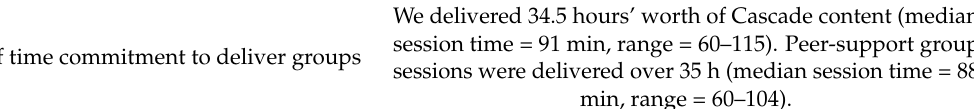
Table 4. Feasibility and acceptability indices within the Cascade